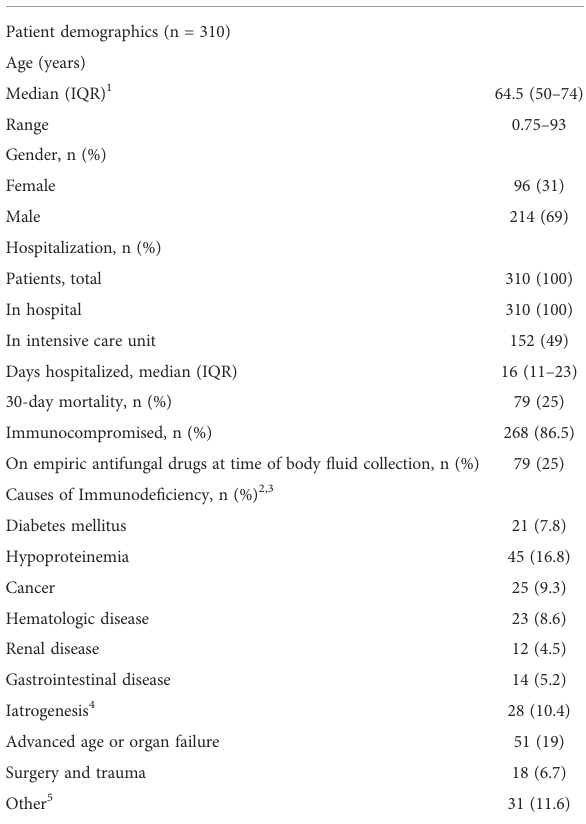
TABLE 1 Patient and sample